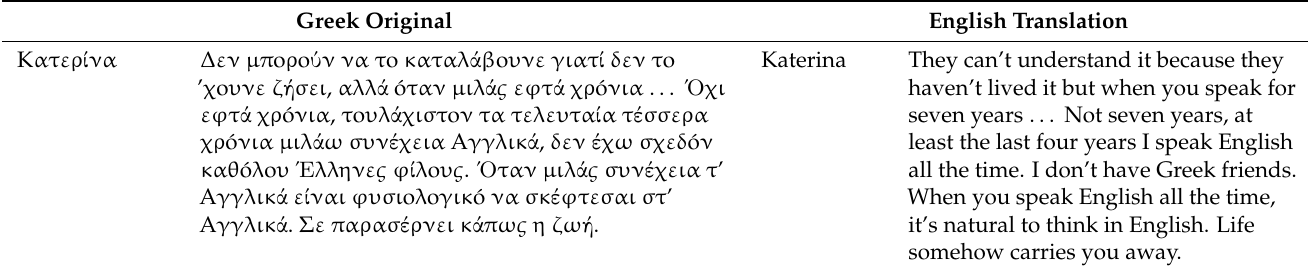
Table 5. “Life somehow carries you away”.